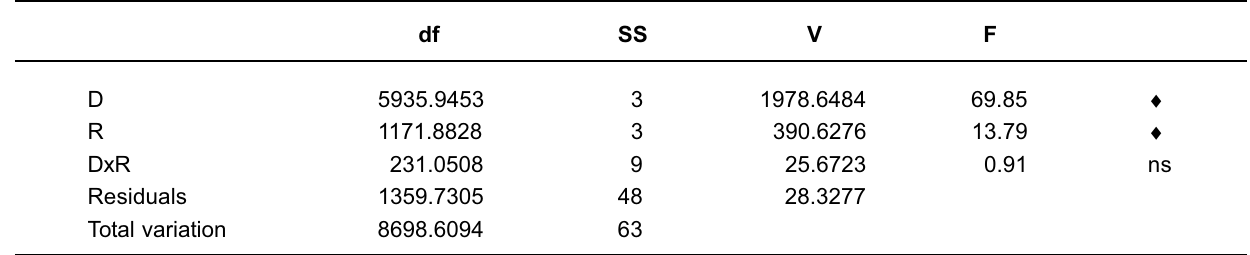
D: dentifrices; R: acrylic resins; ♦ : P<0.05; TABLE 4- Means of mass loss promoted by each dentifrice on the acrylic resins evaluated in this study